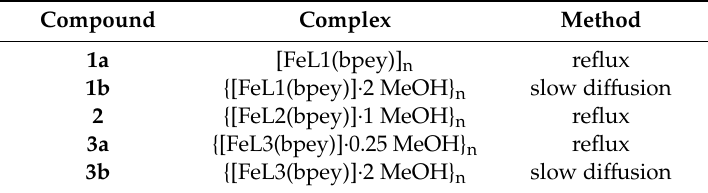
Table 1. Overview of all synthesized iron(II) complexes discussed in this work.